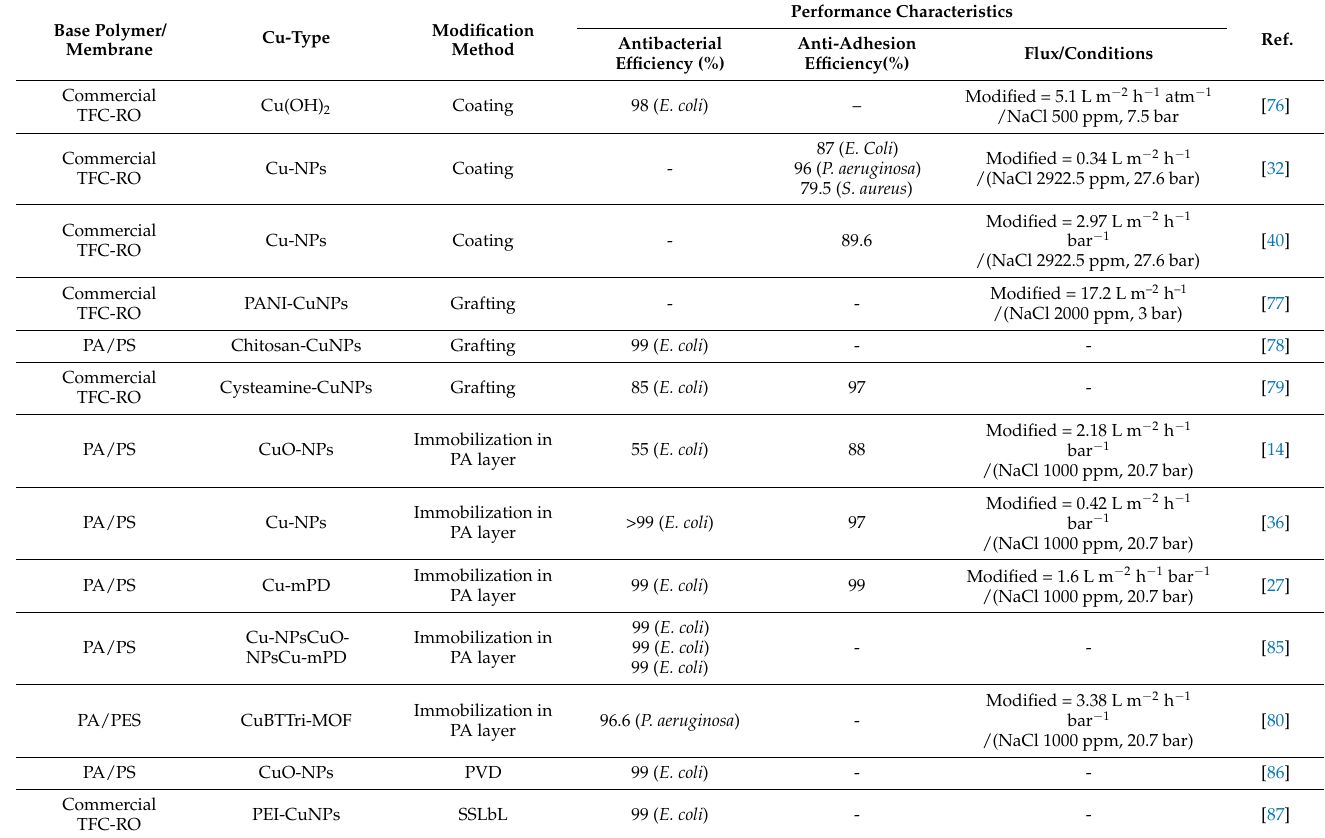
Table 2. Summary of TFC-RO membranes modified with different copper